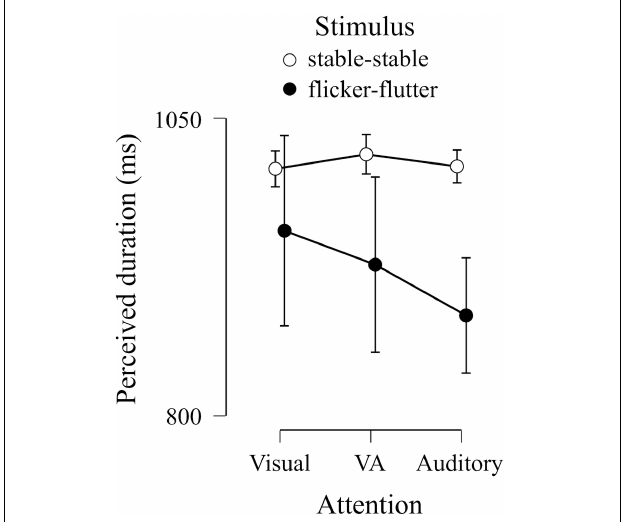
FIGURE 7 | Group results of PSEs in cross-modal session. The dots indicate the means of PSEs in each condition. Error bars indicate a 95% credible interval.